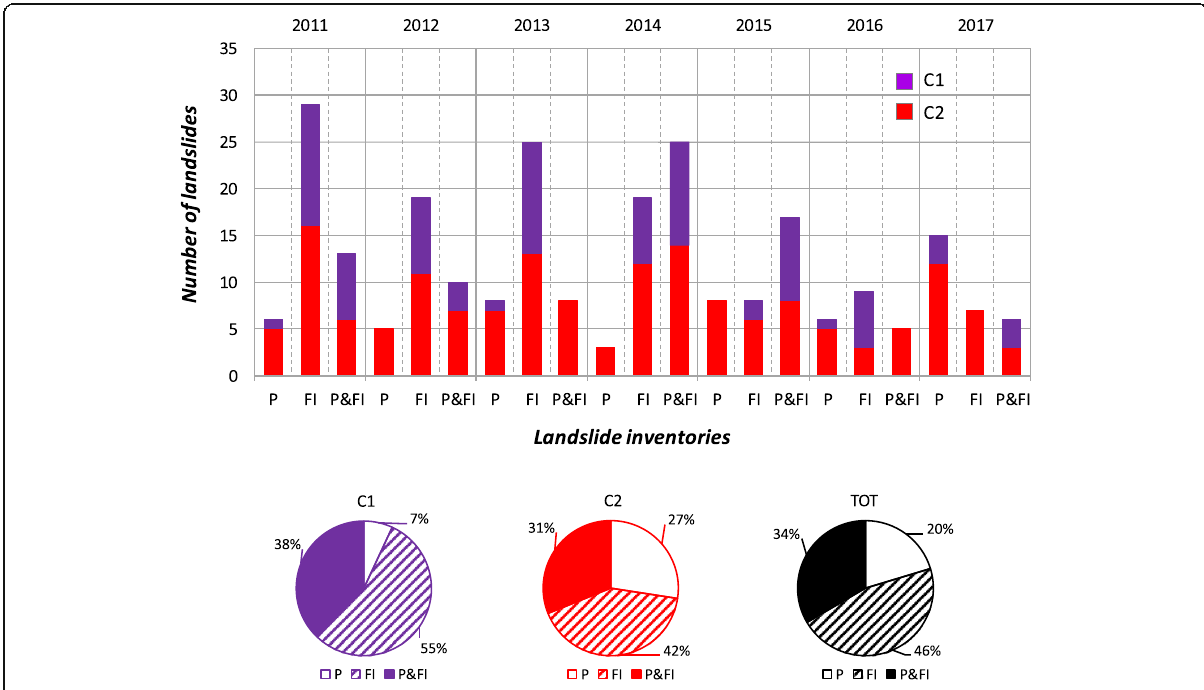
Fig. 10 Comparison between the Polaris (P) and the FraneItalia (FI) inventories, per year and consequence class